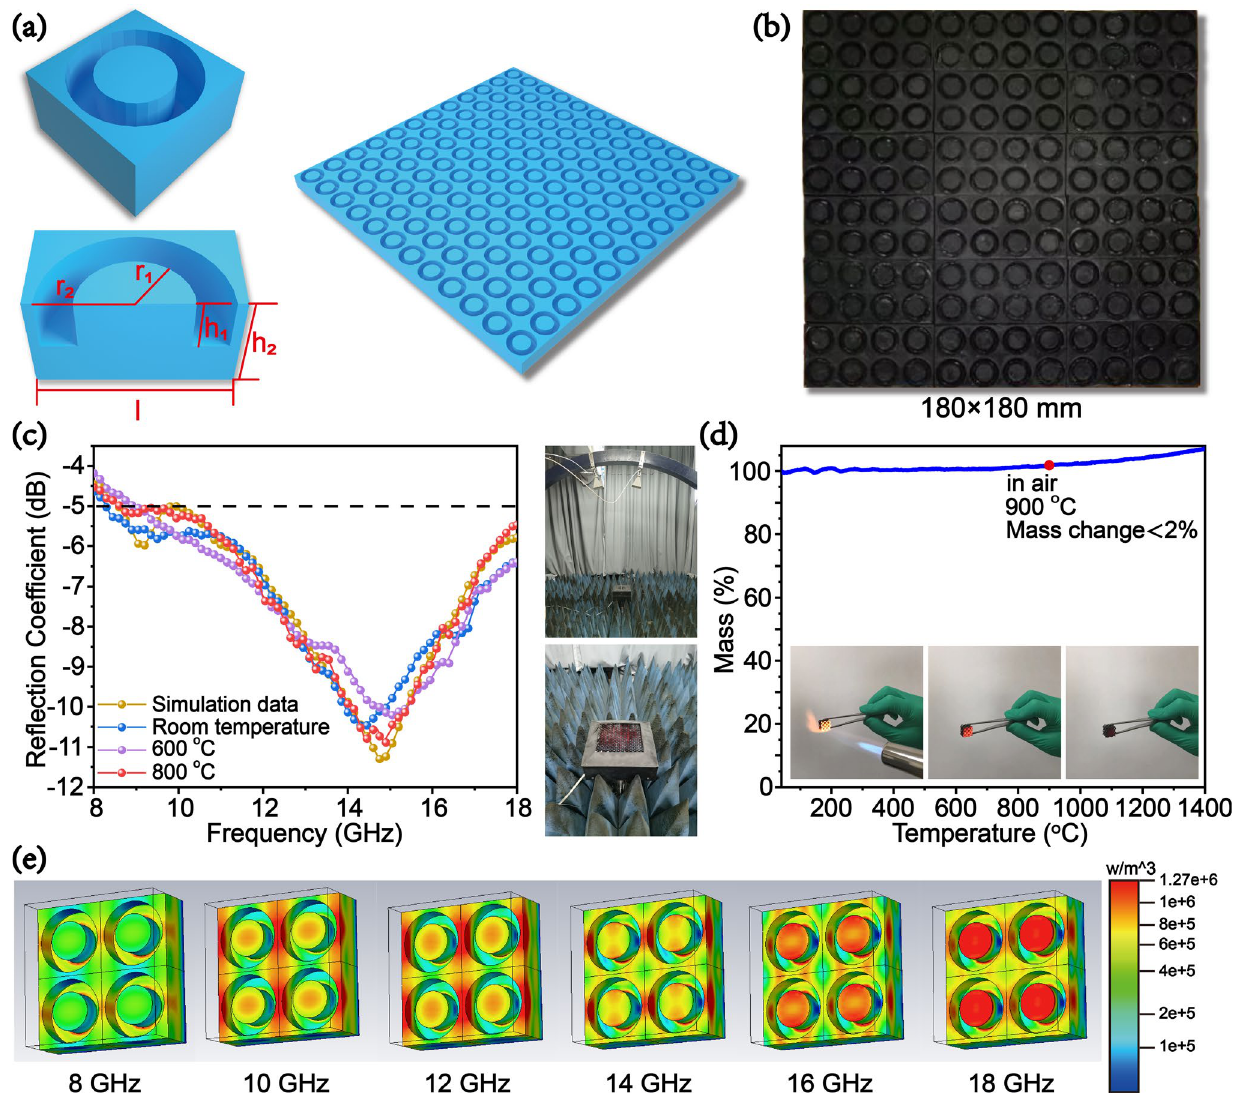
Fig. 5 Design and fabrication of Si–O–C ceramic metamaterial structure for practical application in X-Ku band: a unit and array structure mod- els; b actual photograph of the sample; c comparison of the measured RC data at different temperatures and simulation data; d high-temperature oxidation resistance of Si–O–C ceramic parts; and e energy flow density of the simulated array structure at different